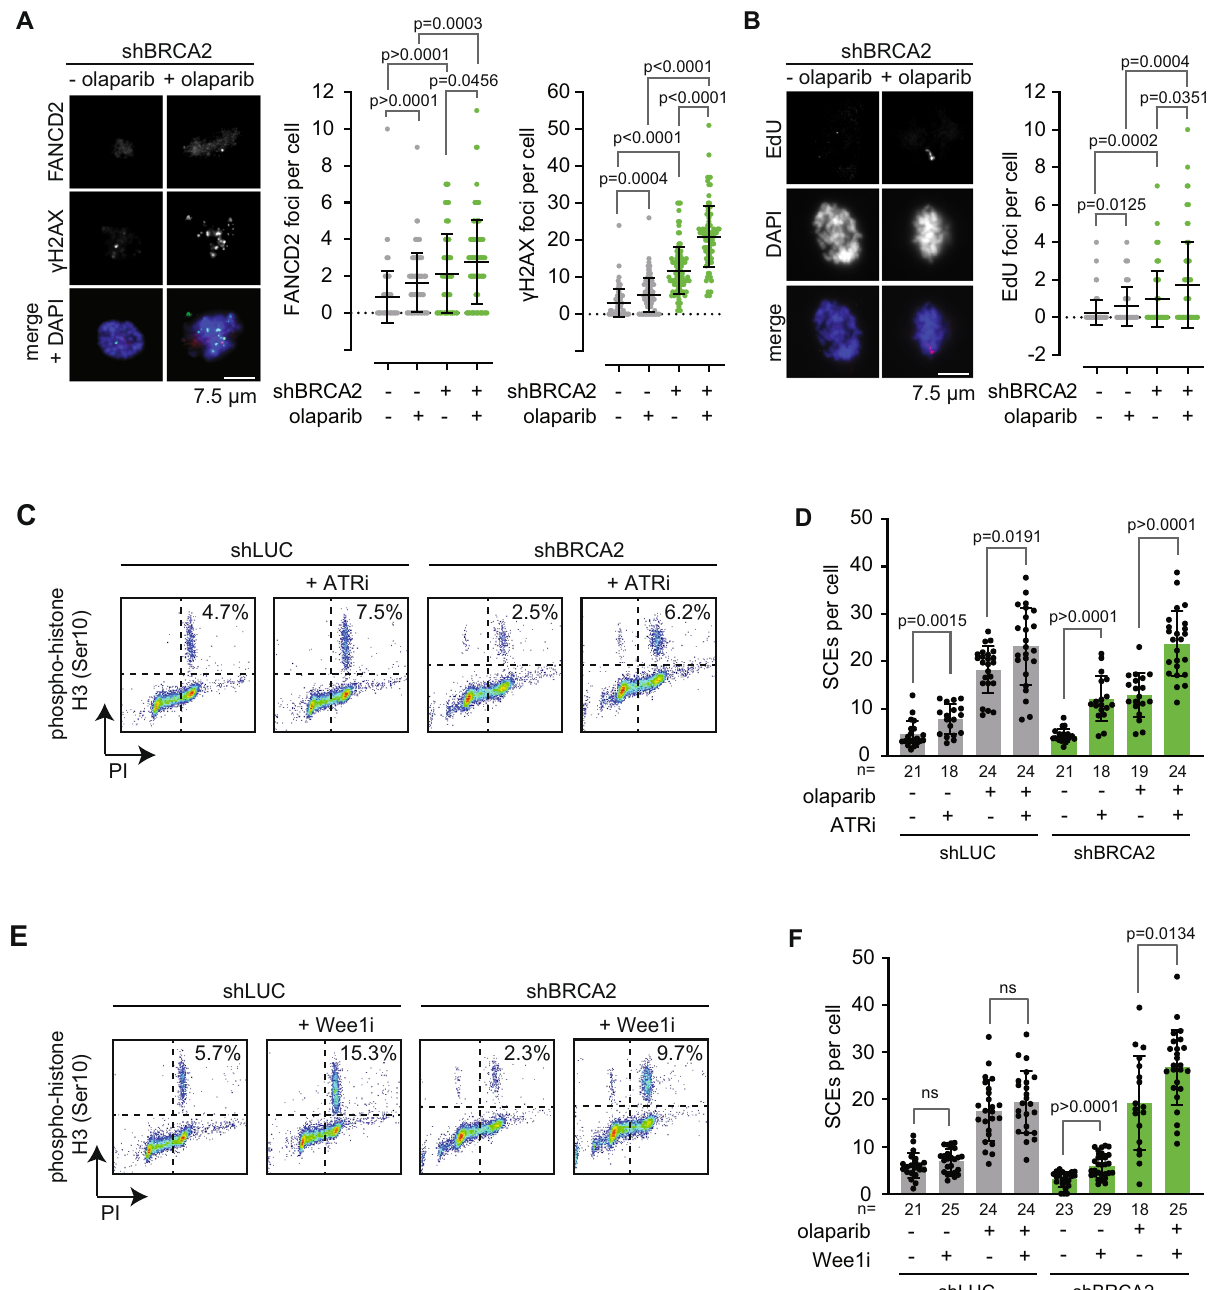
Fig.4|SCEsoriginatefrommitoticprocessingofunder-replicatedDNA.A RPE1 TP53 -/- shBRCA2 were pre-treated with doxycycline (dox), synchronized using RO- 3306 for 4h, and subsequently treated with olaparib where indicated. γ H2AX and FANCD2 foci in mitotic cells were quanti fi ed by immuno fl uorescence microscopy. Meansandstandarddeviationofpooleddatafromthreeindependentexperiments are shown, with n =30 mitoses per experiment. B RPE1 TP53 -/- shBRCA2 were treatedasforpanel A .24hafterolaparibtreatment,cellswereincubatedfor25min withEdU.MitoticEdUfociwerequanti fi edin n =30mitosesperexperiment.Means and standard deviation of pooled data from three independent experiments are shown. C , D RPE1 TP53 -/- shBRCA2cellsweretreatedwithdoxycycline(dox)for48h, witholaparibfor24h,withorwithouttheATRinhibitorVE-821(ATRi)for3h.Cells were treated with colcemid for 3h before harvesting, fi xed and stained for the